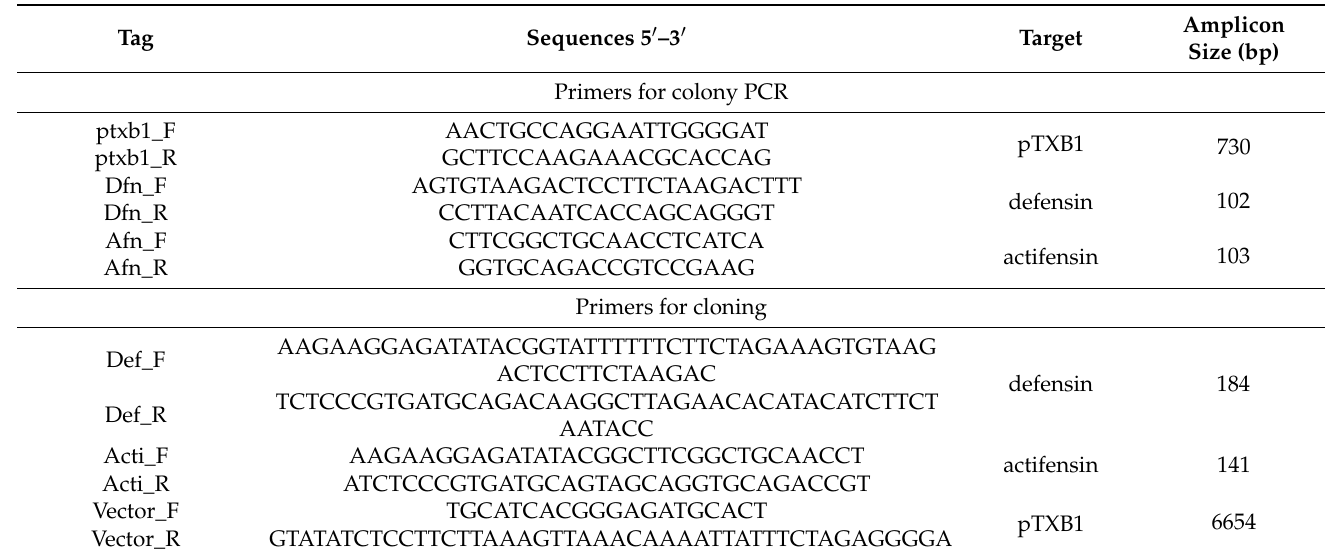
Table 4. Nucleotide sequences of primers used in this